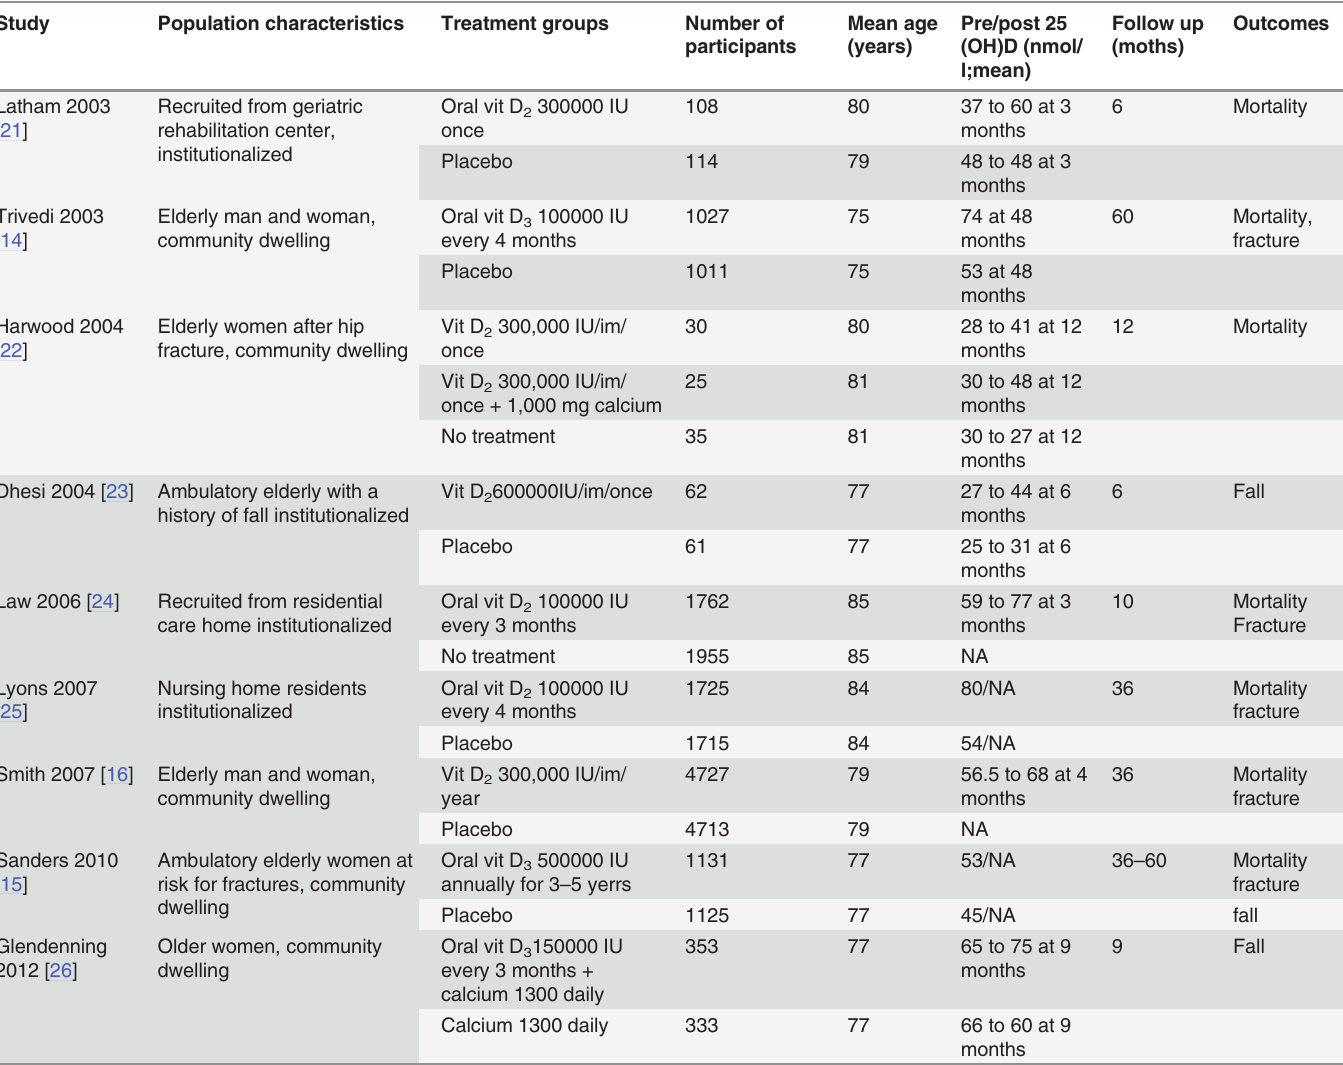
Table 1. Characteristics of studies included in primary